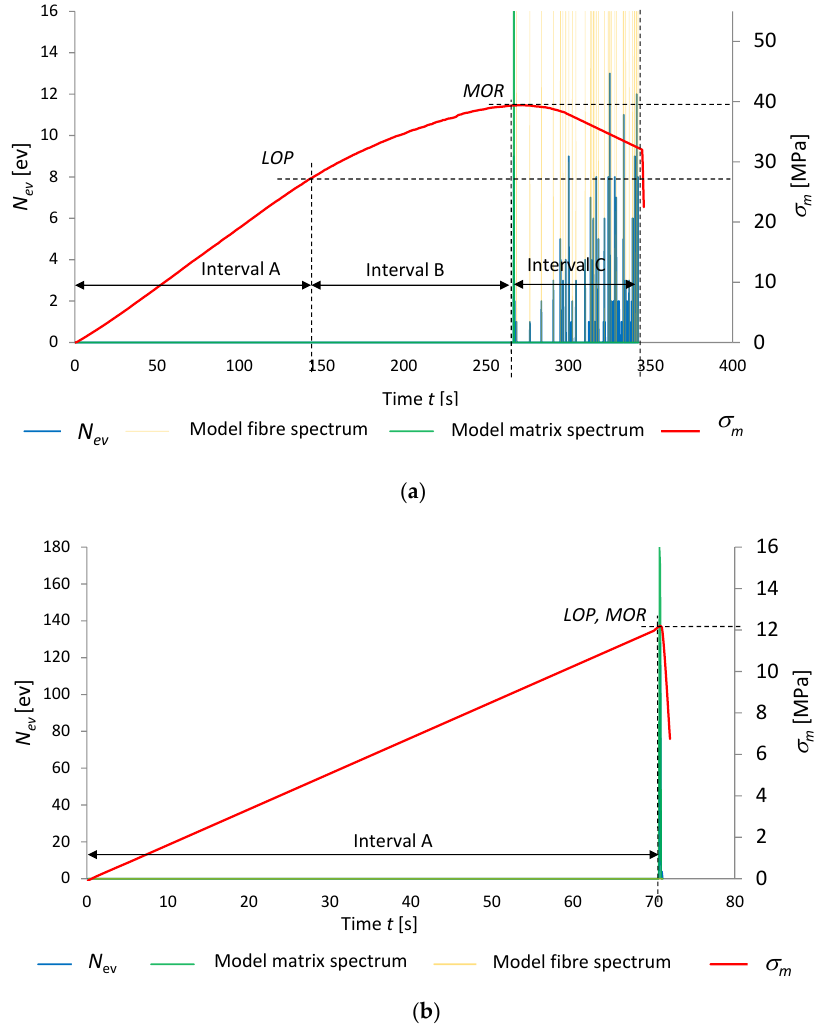
Figure 9. Events rate N ev , and bending stress σ m versus time under influence of fire, with marked identification of model spectral characteristics: ( a ) series C R , ( b ) series C T .